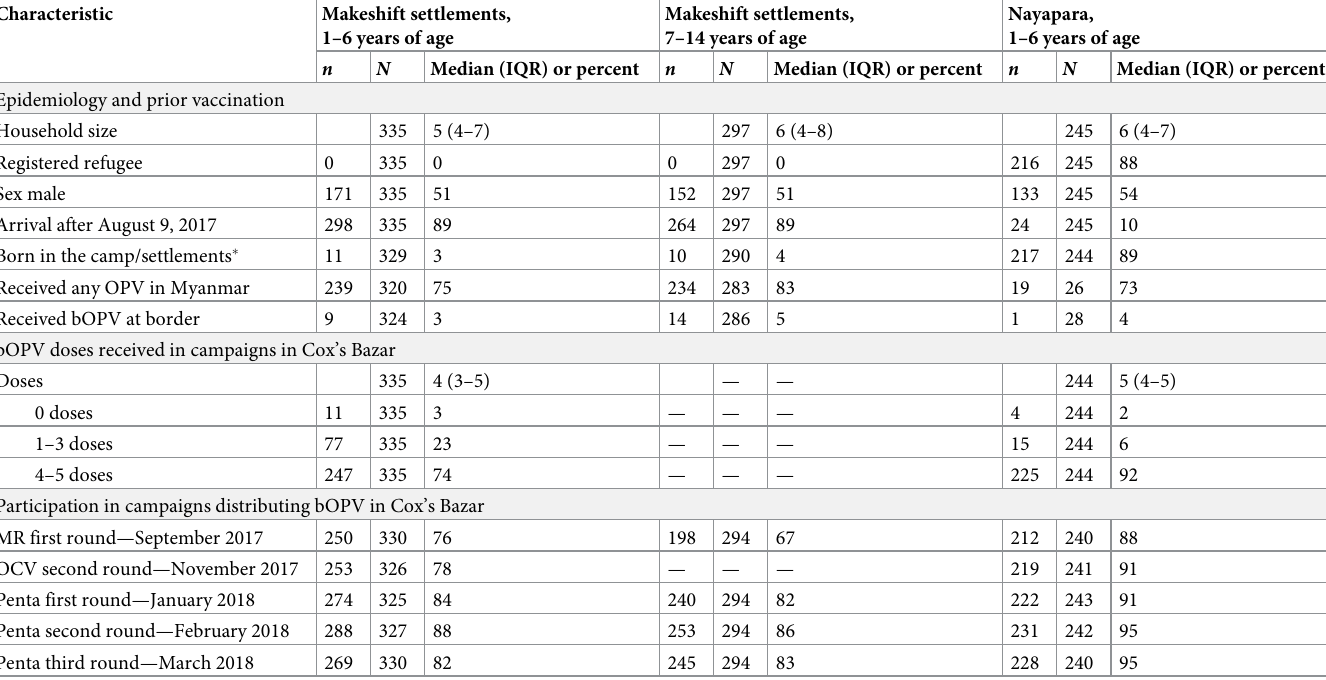
Table 1. Demographic and vaccination history of Rohingya children with DBS sample available, Cox’s Bazar, Bangladesh, April–May 2018.